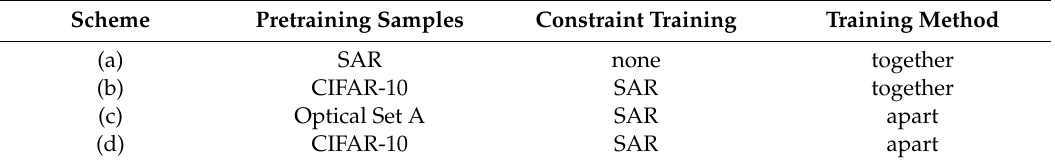
Table 4. The di ff erent training samples and methods in the training step.